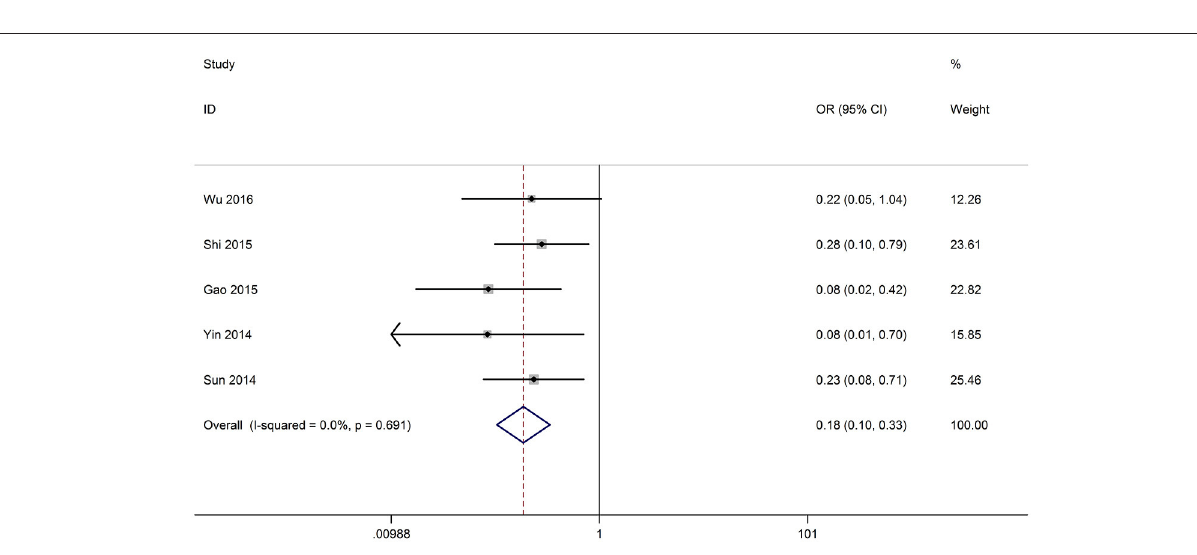
FIGURE 4 | Forest plot for the correlation between GAS5 expression levels and HTS in different cancer patients.